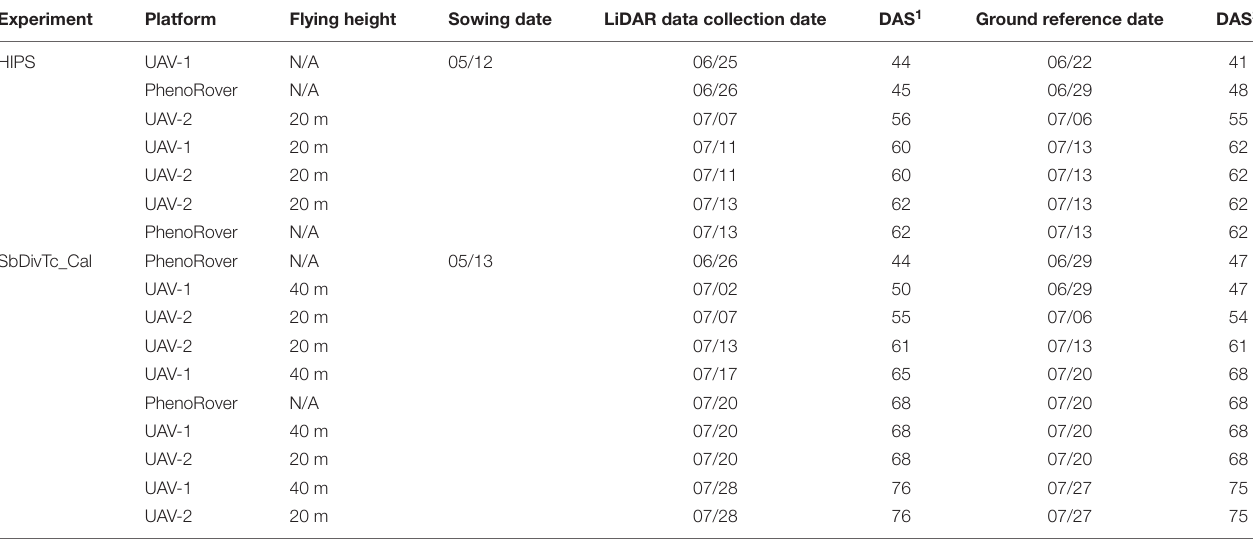
TABLE 3 | Days after sowing (DAS) relative to the available ground reference and LiDAR data in two experiments over SbDivTc_Cal and HIPS. Experiment